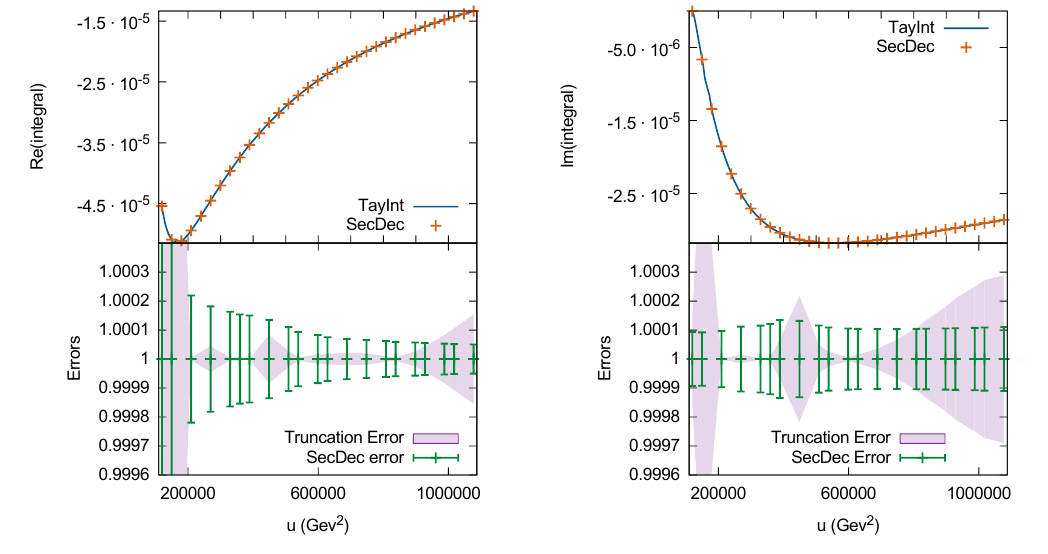
Figure 14 . I10 over the threshold, calculated at O ( (cid:15) 0 ) with a sixth-order series expansion choosing m 2 = 1 p m 1 and m 1 = 173 GeV. The lower plots show the relative uncertainties of the TayInt 2 and numerical SecDec results,